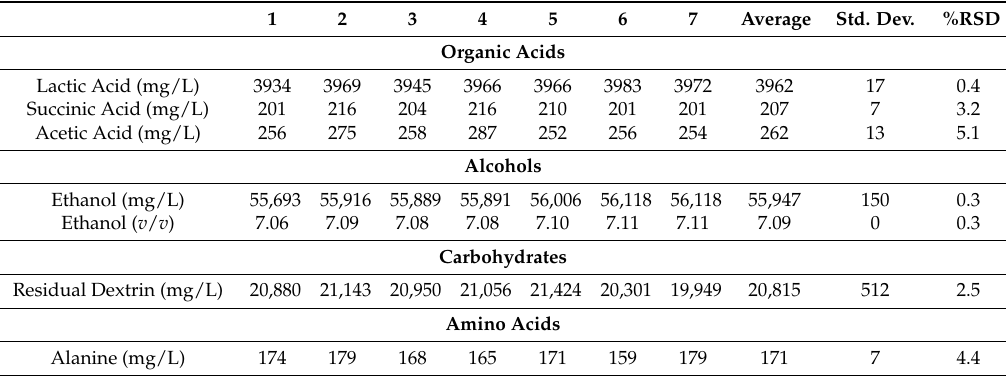
Table 4. 1 H NMR analysis—data processing reproducibility.